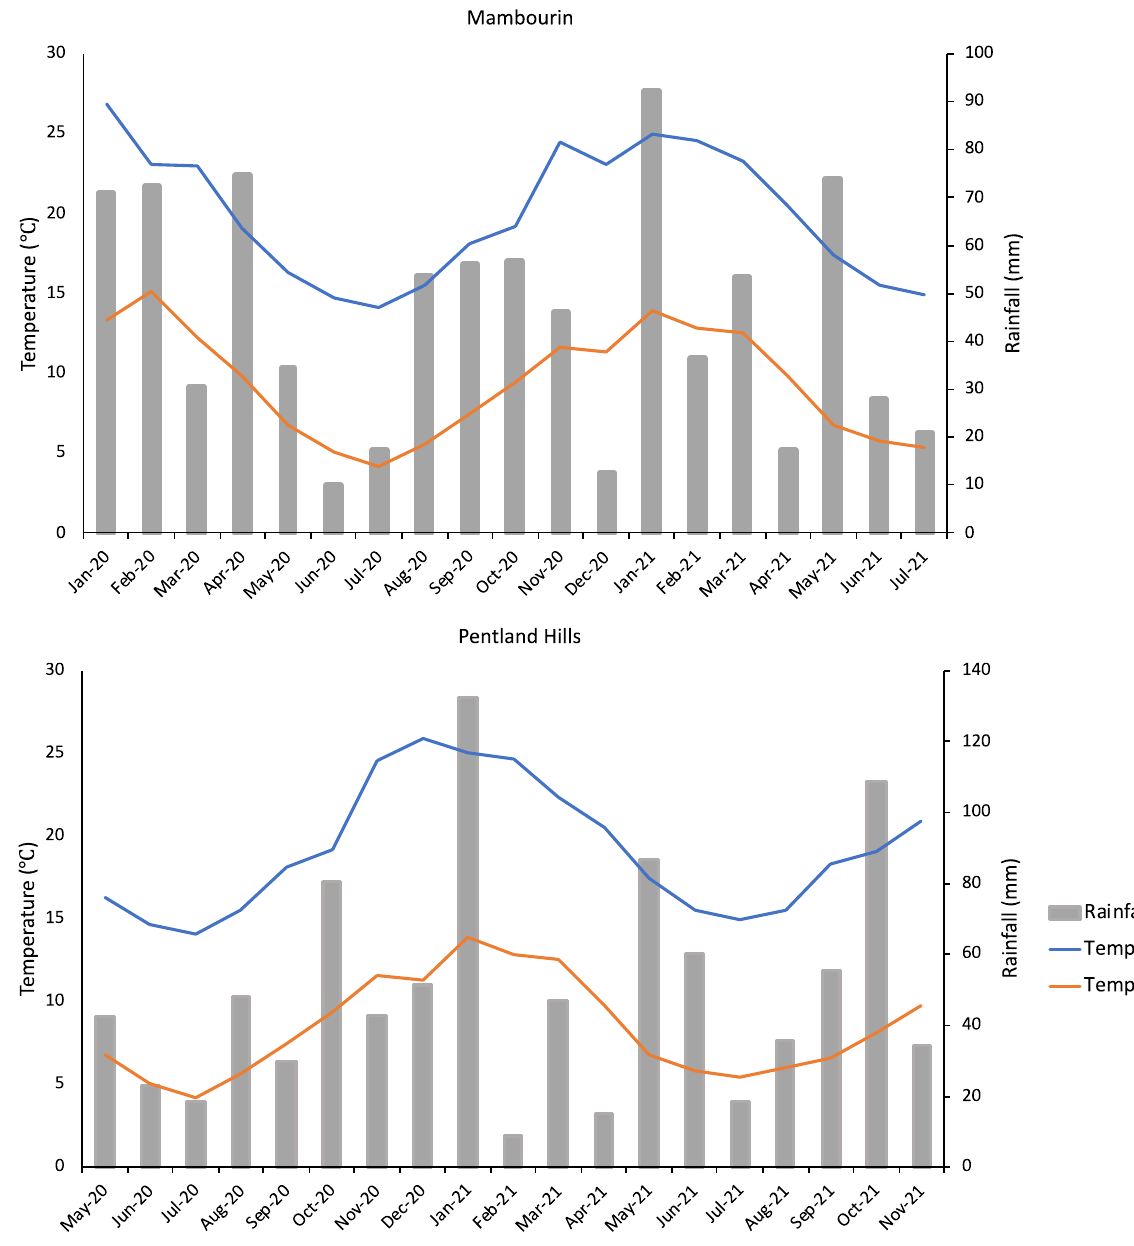
Figure 3. The climate data for Pentland Hills and Mambourin for the duration of the seed burial trials at each location. Data were accessed from the Bureau of Meteorology [50]. Temperature and rainfall data for the Mambourin site were taken from Mt. Rothwell weather station, which is located approximately 15 km from this site. The temperature data for Pentland Hills were collected from the Durdidwarrah weather station, located approximately 40 km from the site, and the rainfall data were collected from the Merrimu Reservoir weather station, located approximately 13 km from the Pentland Hills site.